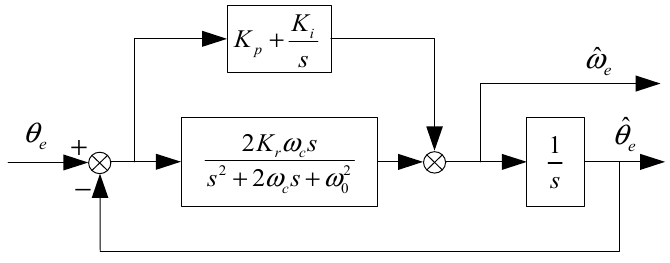
Figure 11. Control block diagram of the proposed estimator.